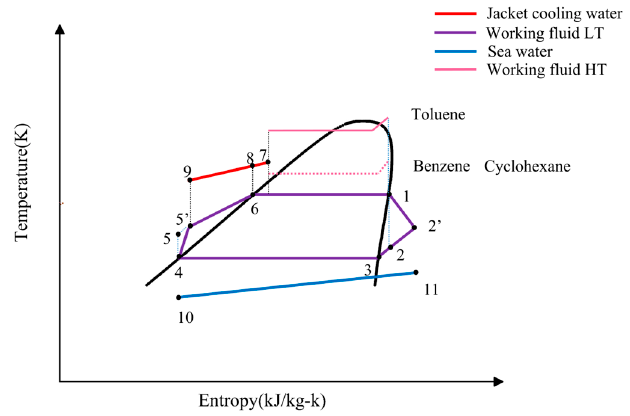
Figure 7. T-s diagram of the LT loop in case a.